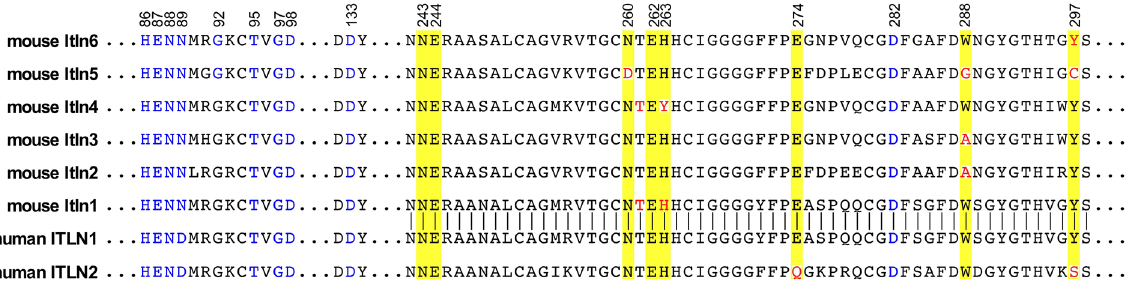
Figure 7. Comparison of the calcium- and glycan-binding regions of mouse and human intelectins. The aligned partial amino acid sequences of human and mice intelectins are shown (amino acid residue numbering from human ITLN1). Amino acids previously shown 2 to mediate calcium coordination are shown in blue and those mediating glycan binding highlighted with yellow. Residues identical to those previously shown to bind carbohydrate in human ITLN1 are shown in black within the yellow background and the polymorphic amino acids are shown in red.